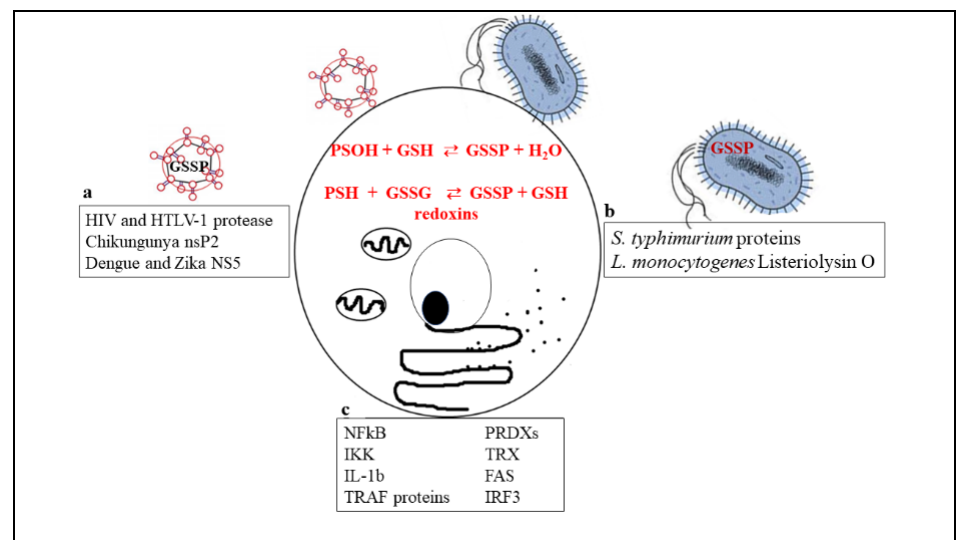
Figure 1. Biochemical reactions through which glutathionylated proteins can be formed and a list of proteins that have been shown to undergo glutathionylation in viruses ( a ), bacteria ( b ), or cellular immune/inflammatory pathways ( c ).